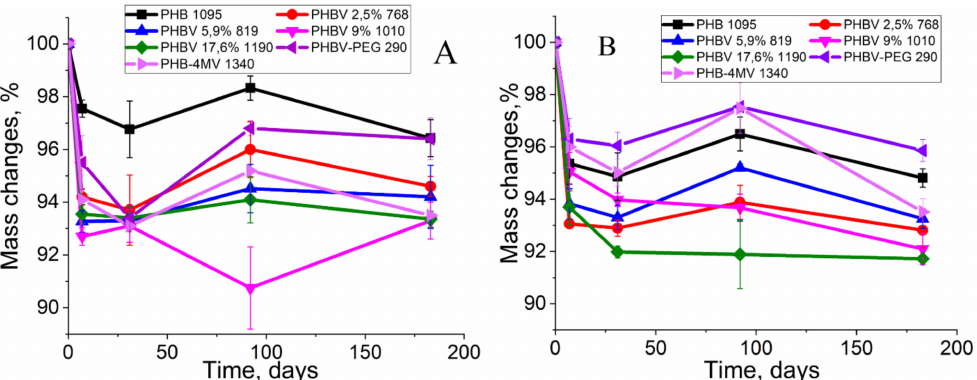
Figure 1. The change in the mass of poly(3-hydroxybutyrate) (PHB), poly(3-hydroxybutyrate-co-3- hydroxyvalerate) (PHBV) (with a di ff erent molar content of hydroxyvalerate (HV)), PHB-4 methylvalerate (MV), PHBV-polyethylene glycol (PEG) films during degradation for 6 months in phosphate bu ff er solution ( A ) and in the same phosphate bu ff er solution supplemented with the pancreatic lipase (0.25 mg / mL) ( B ).